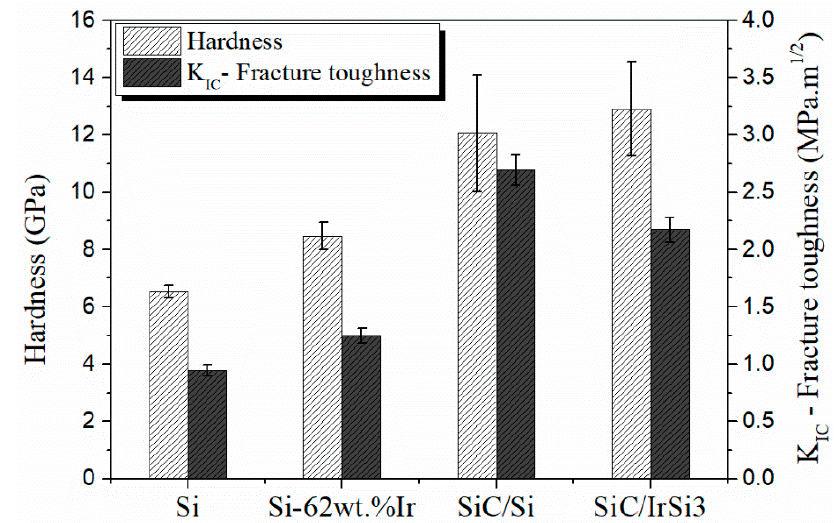
Figure 4. Vickers microhardness and indentation fracture toughness (KC) measure for metals (Si and Si-62 wt% Ir) and composite materials (Si-Si and SiC-IrSi 3 ). Bars indicate the average value and the segments indicate the standard deviation. Five indentations were made for each sample.